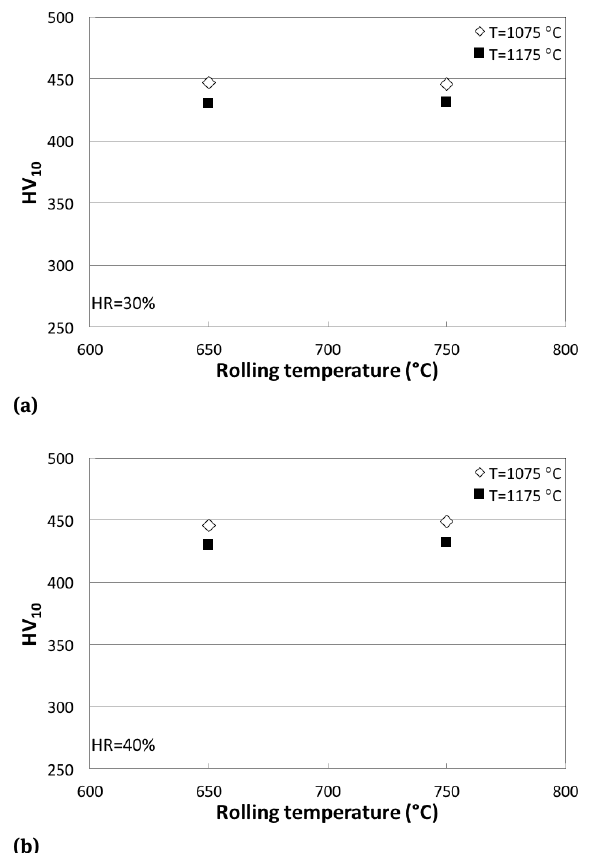
Figure 1: Effect of thermo-mechanical parameters on EUROFER 97 hardness (a: 30% hot reduction, b: 40% hot